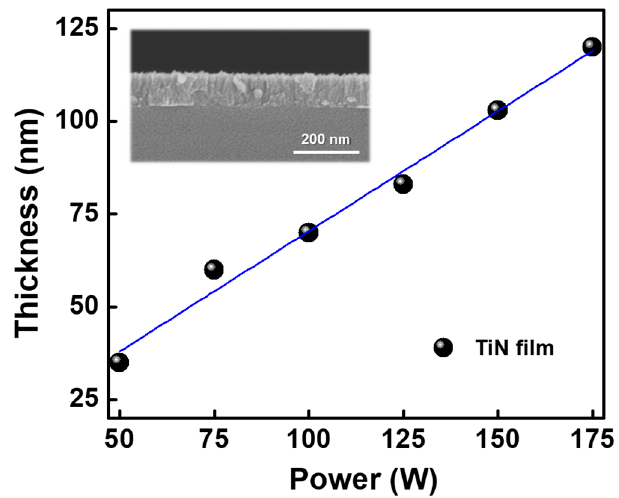
Figure 1. Variation in thickness of TiN thin film on the Si/SiO 2 <100> substrate with various source power.